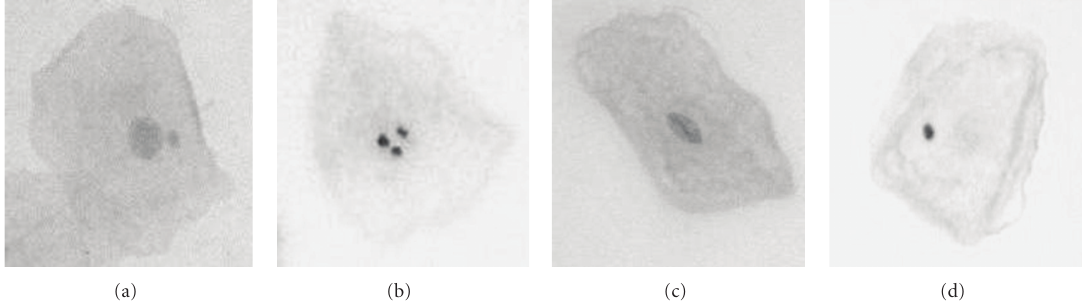
Figure 1: Cells presenting a micronucleus (a) karyorrhexis (b), condensed chromatin (c), and pyknosis